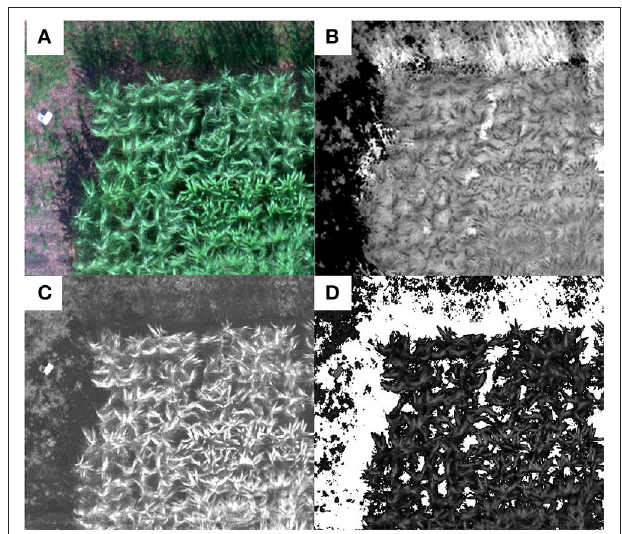
FIGURE 3 | Shadow removal and vegetation segmentation from soil background using an example plot: (A) the RGB composite of the multispectral mosaic, (B) NDVI map showing the shaded area had higher NDVI values than canopy pixels, (C) excess green (ExG) image in which both the soil and shaded pixels have lower values than the sunlit vegetation pixels, and (D) mask for vegetation pixels (white pixels are soil and shaded pixels).